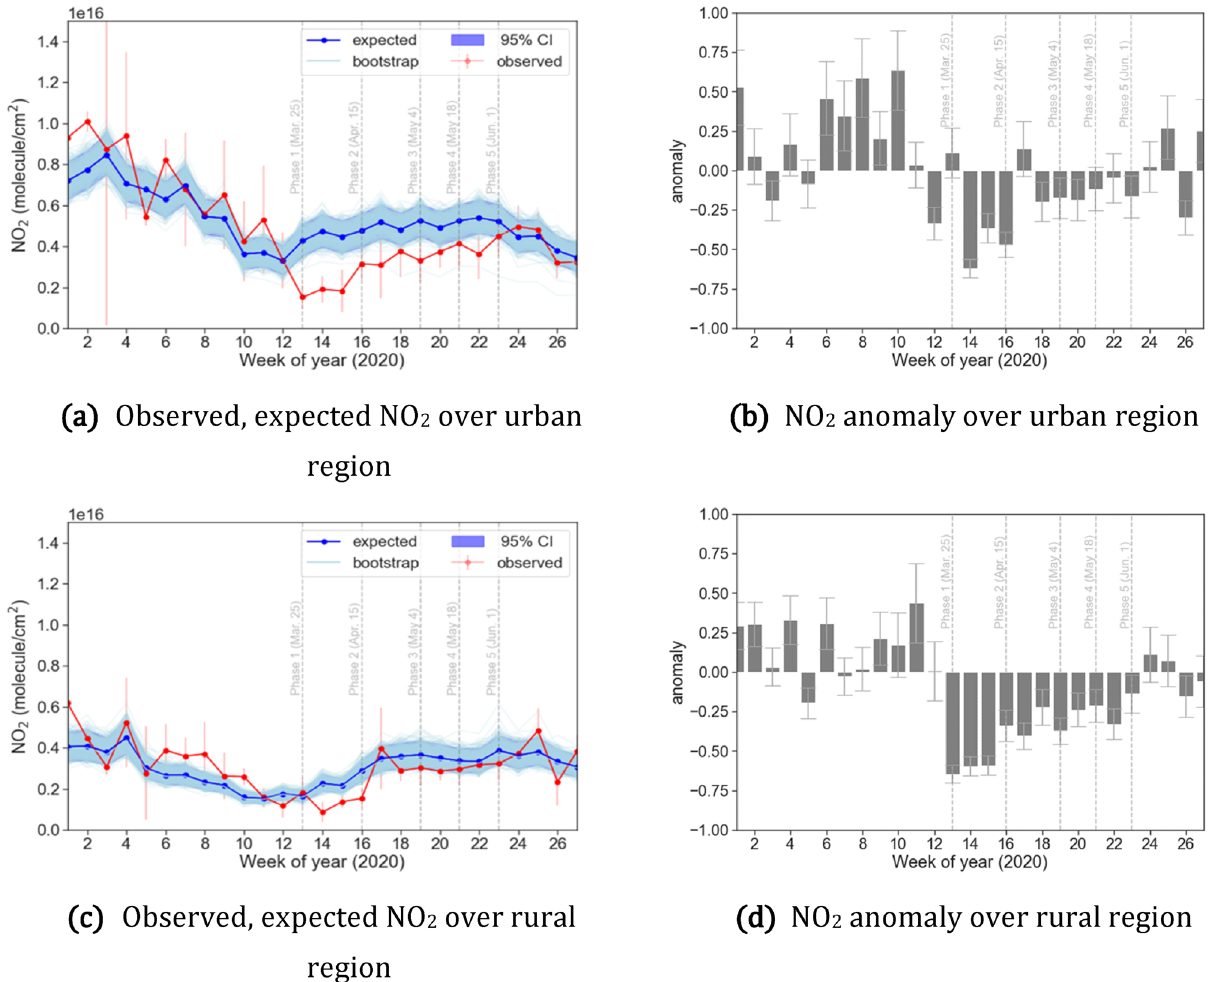
Figure 2. Weekly mean of observed ( C o ) and expected ( C B ) OMI NO 2 concentration (left) and the anomaly between the observed and expected concentration (right) over Delhi (top) and rural Fatehabad (bottom). The anomaly range corresponds to 95% prediction intervals. Anomaly metric was calculated following Eq.